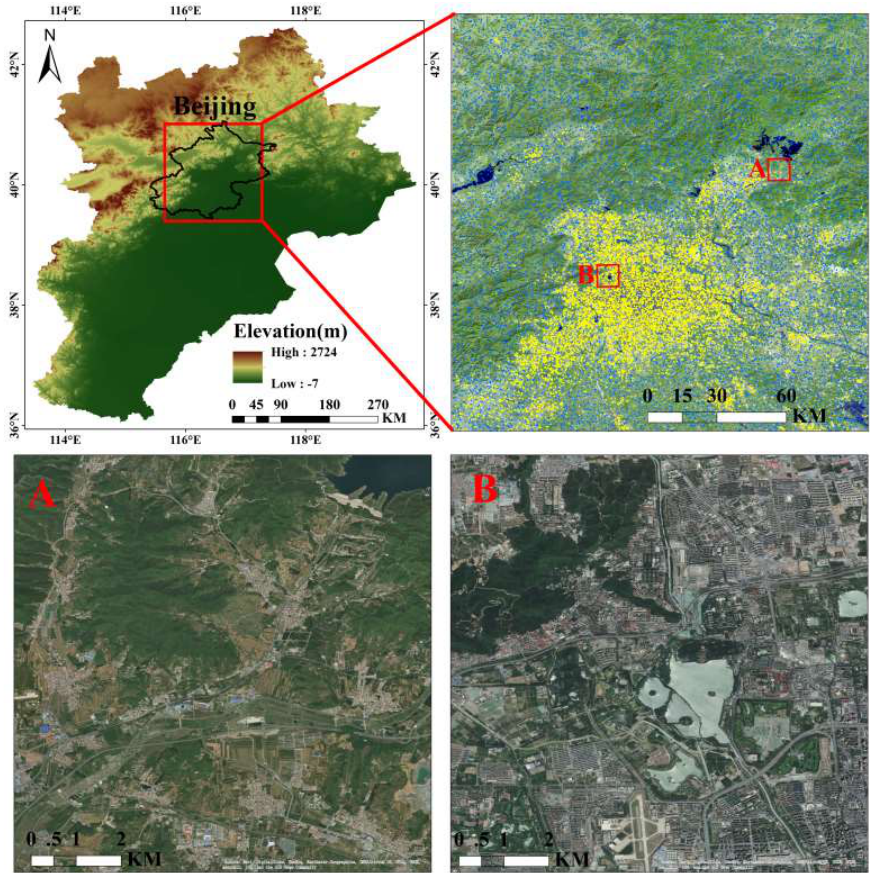
Figure 1. Research area and samples (Subregion B is an urban central region with dense buildings, while subregion A is a suburban region with sparse buildings).